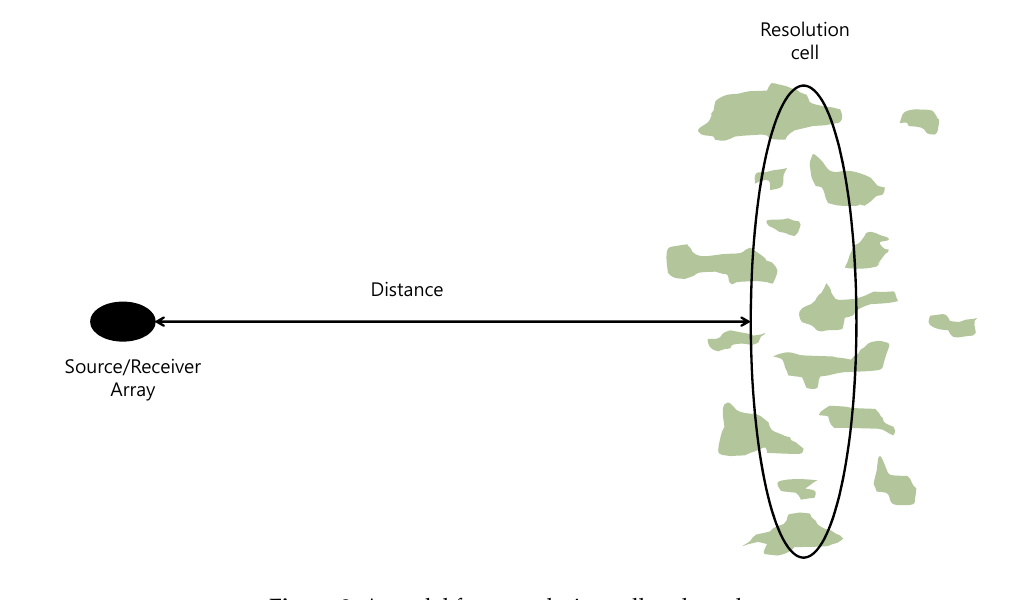
Figure 2. A model for a resolution cell and